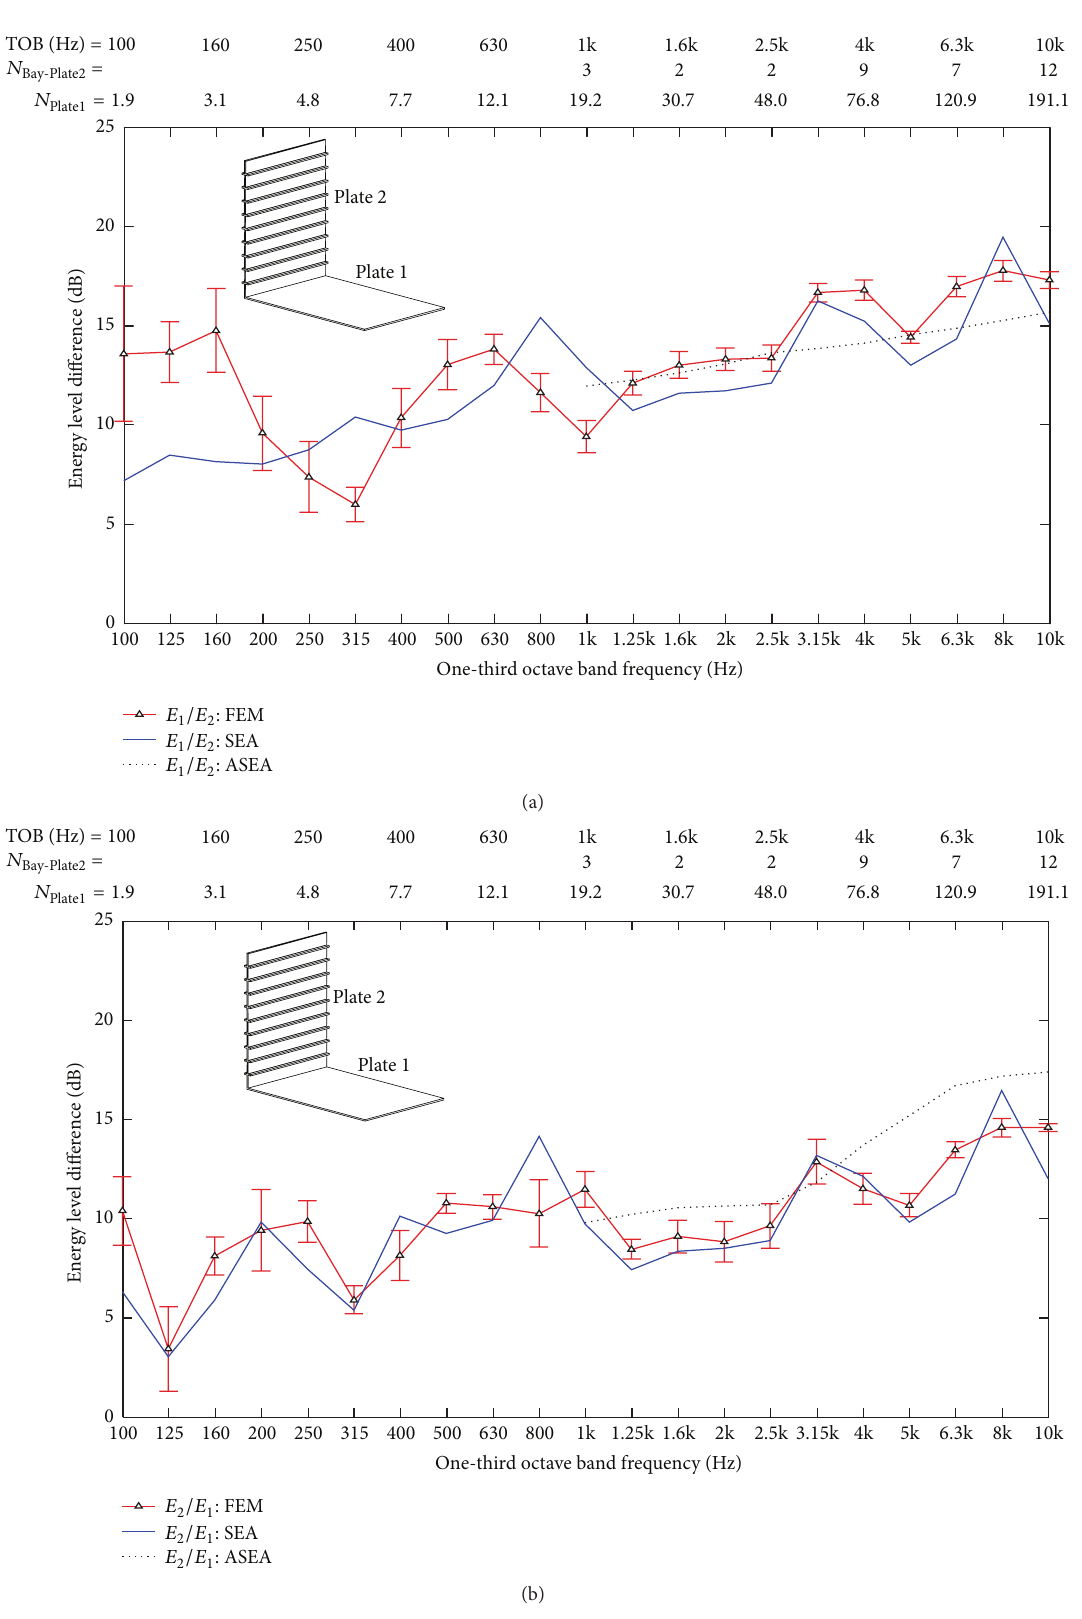
Figure 9: L-junction A. Energy level differences between the isotropic, homogeneous plate (Plate 1) and periodic ribbed plate (Plate 2) with excitation of (a) Plate 1 and (b) Plate